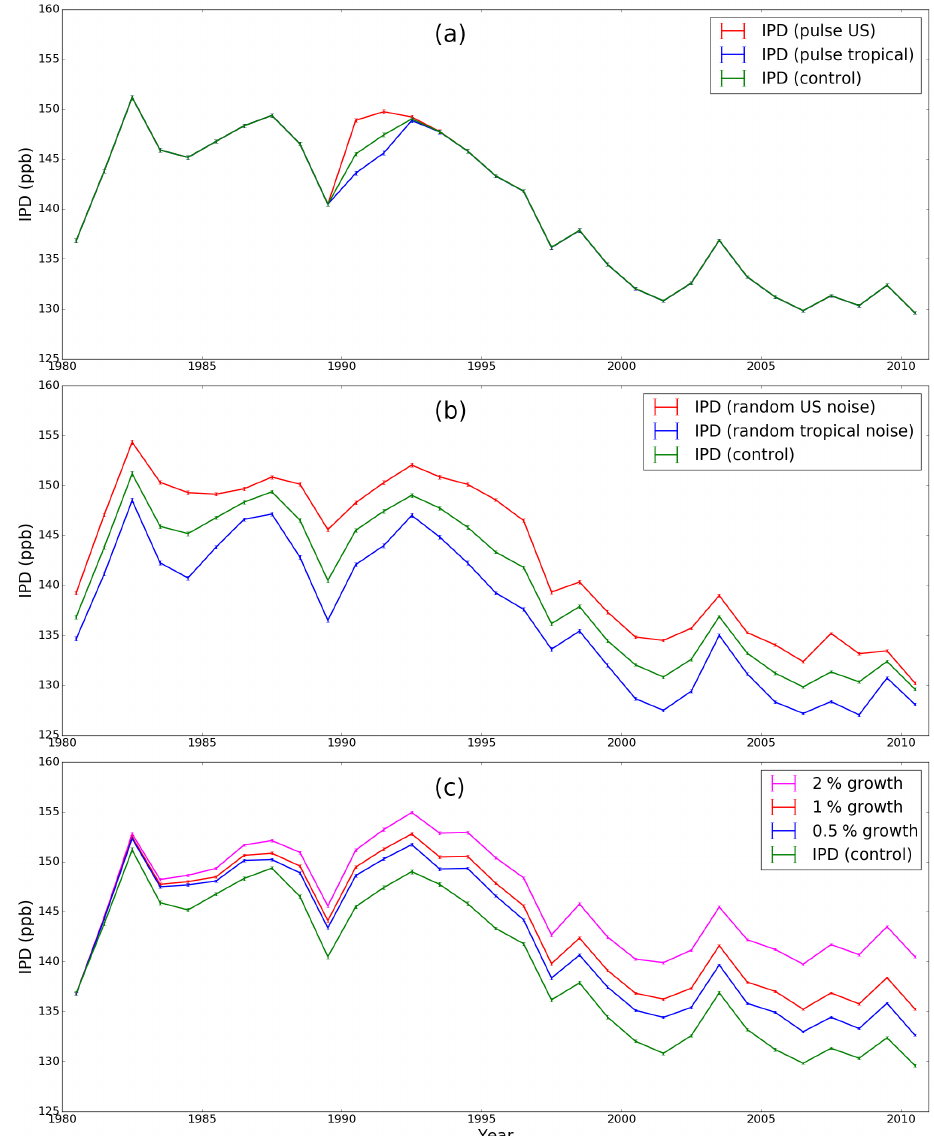
Figure B2. The model IPD corresponding to the control and all the sensitivity experiments described in the main